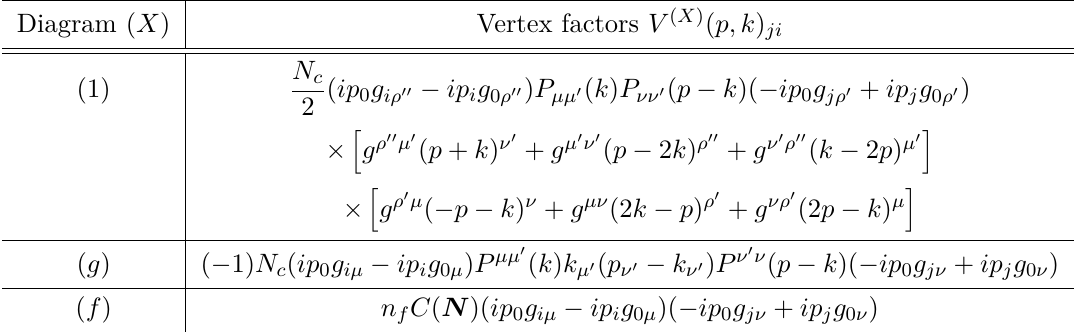
Table 2. Summary of vertex factors of diagrams with 4 propagators contributing to The free µ, ν indices in the fermion loop diagram ( f ) are to be contracted with the free µ, ν indices in the corresponding propagator